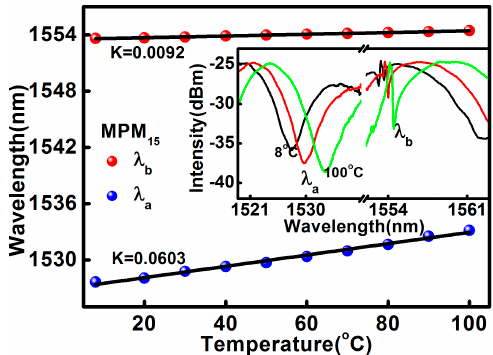
Figure 7. The temperature characterization of MPM 15 .